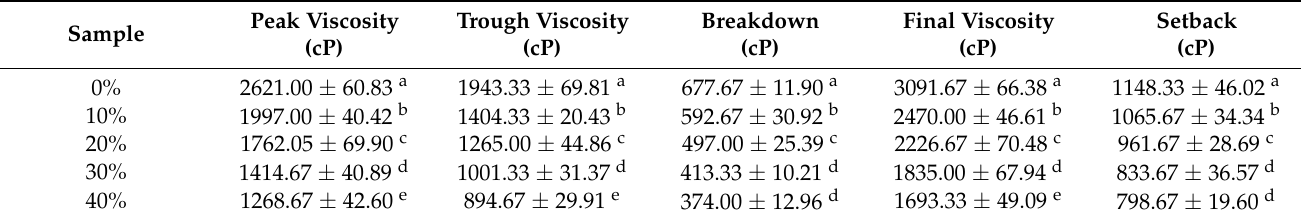
Table 4. Pasting properties of GBP/wheat flour mixtures.